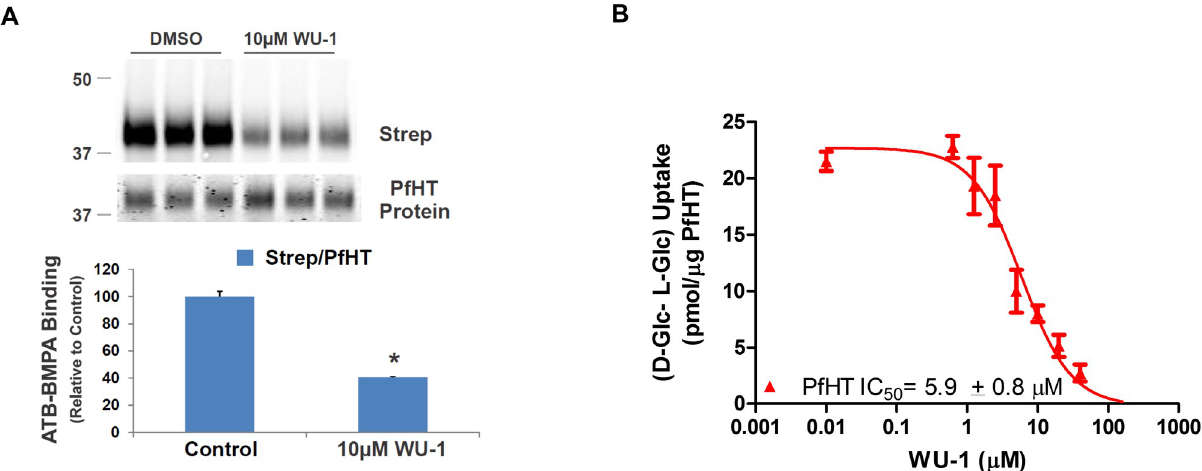
Fig 8. WU-1 directly inhibits both the binding of the glucose analogue (ATB-BMPA) to PfHT and PfHT transport activity. A) Biotinylated ATB-BMPA, a bis-mannose containing photolabel, binds to the glucose binding site of PfHT. Liposomes containing 0.65 μ g PfHT were preincubated with ± 10 μ M WU-1 prior to labeling with biotinylated ATB-BMPA. PfHT bound with biotinylated ATB-BMPA was analyzed by immunoblot analysis using a fluorescently labeled streptavidin (Strep). The strep signal was normalized to the amount of PfHT protein. Data are expressed as the means ± SEM., n = 3; ( � ), p < 0.05 vs. vehicle control as determined by the paired Student’s t test. B) WU-1 inhibits the specific uptake ([ 3 H]-D-glucose minus ([ 3 H]-L-glucose) into PfHT-containing liposomes. Different concentrations of WU-1 were added to the liposomes 20 min prior to the initiation of the transport reaction. Uptake (quenched after 50 sec) was normalized to the amount of PfHT in the liposomes. Data were fit by nonlinear regression analysis using GraphPad Prism 6.0 software to calculate the IC 50 for WU-1. Data are expressed as mean ± SEM of three independent experiments.